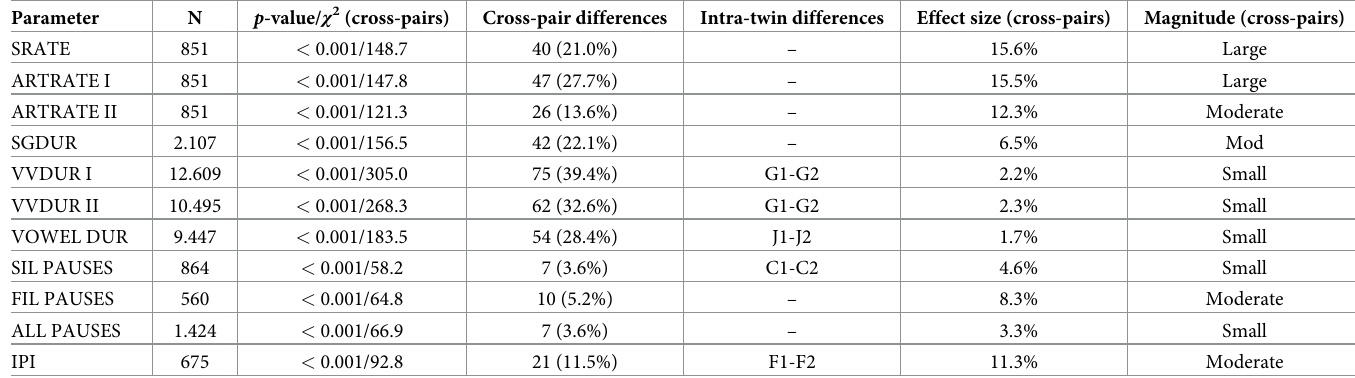
Table 2. Number of data points, p -value and χ 2 for the Kruskal-wallis test (df = 19), number of significant differences among all speakers and intra-twin pairs (Dunn’s Multiple Comparison Test, df = 19, two-tailed test, p < 0.025 with Bonferroni adjustment), followed by effect sizes ( η 2 ). Parameter N